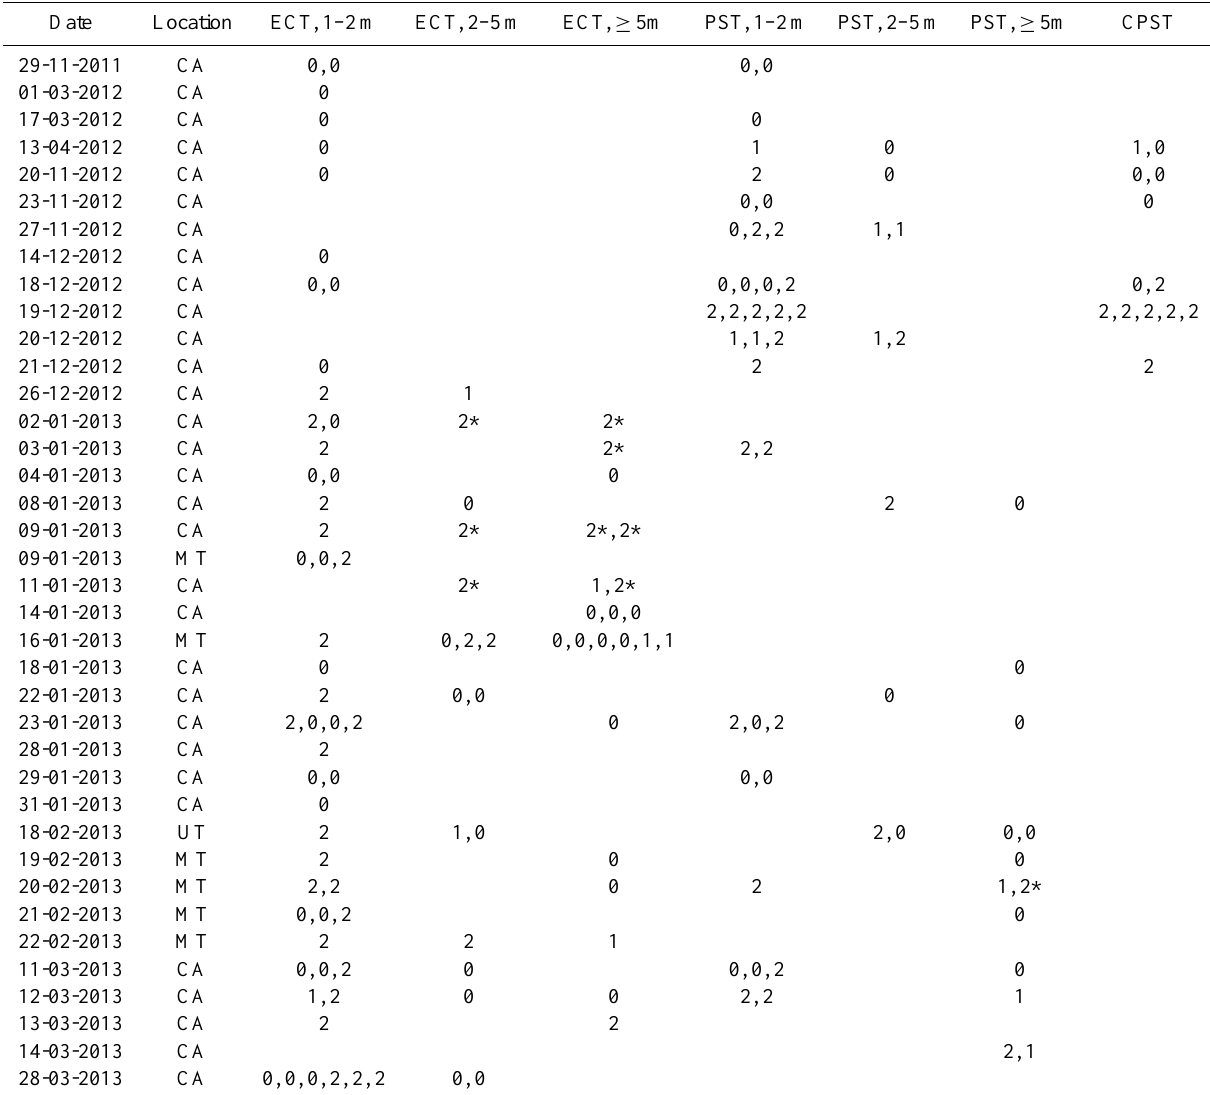
Table 1. Summary of propagation test results. Tests listed by location, date, and propagation code: 0 is no propagation, 1 is partial propagation, 2 is full propagation. Selected tests (Table 2) are marked with an asterisk.